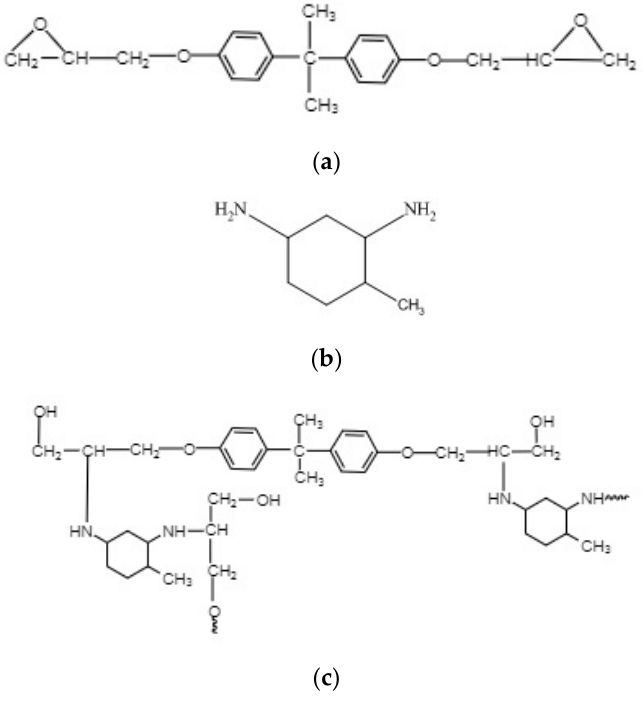
Figure 1. Chemical structures of the epoxy system used to prepare the neat epoxy and CFRP plates: ( a ) E51epoxy ( b ) HTDA and ( c ) cured epoxy resin.